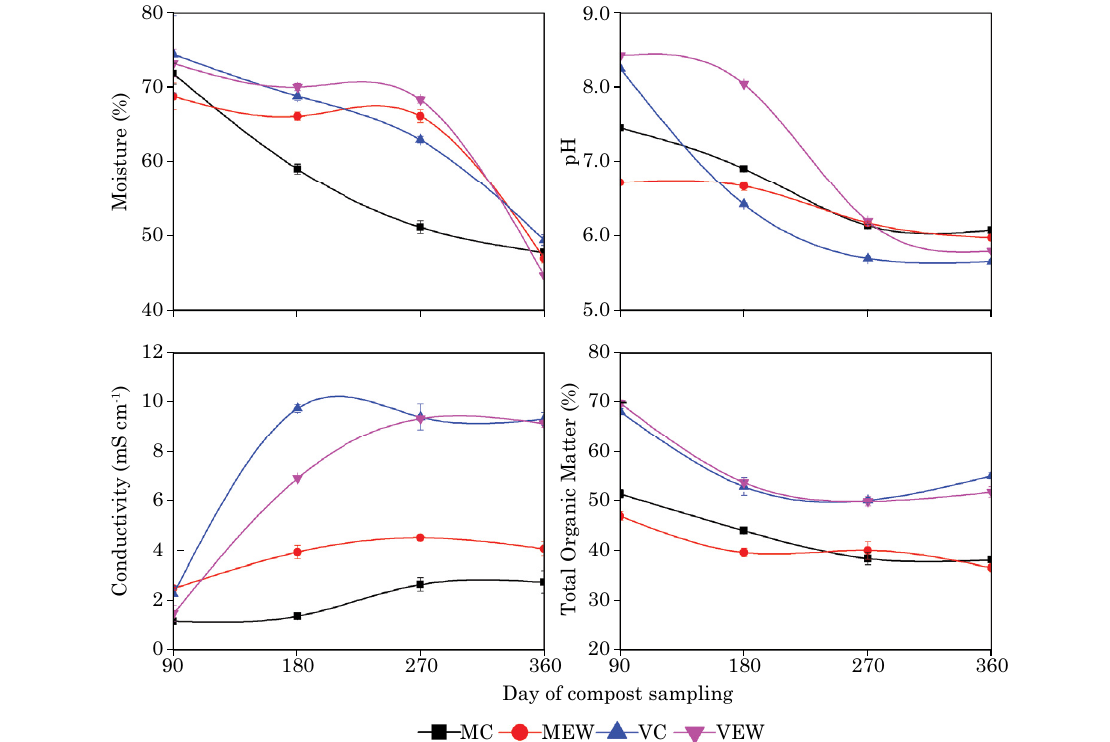
figure 2. Diagram of variations in moisture, pH, electrical conductivity, and organic matter at compost sampling after 90, 180, 270 and 360 days. mC: manure control; meW: manure electronic waste; vC: vegetable control; veW: vegetable electronic